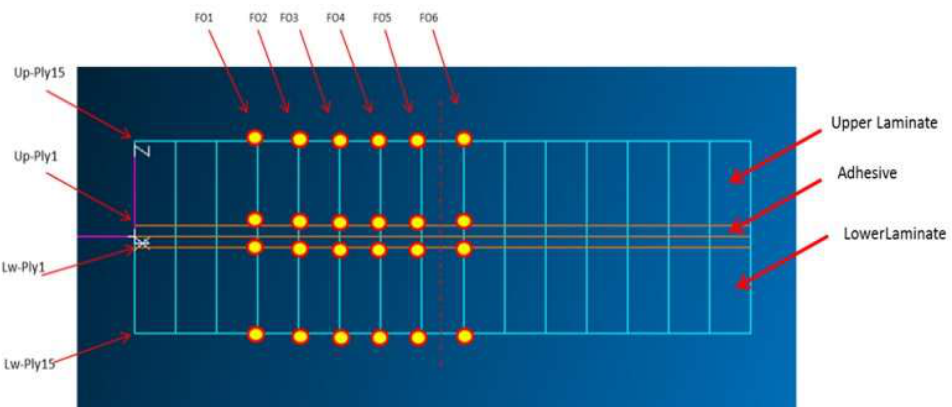
Figure 3. Location of the virtual distributed optical fibers.